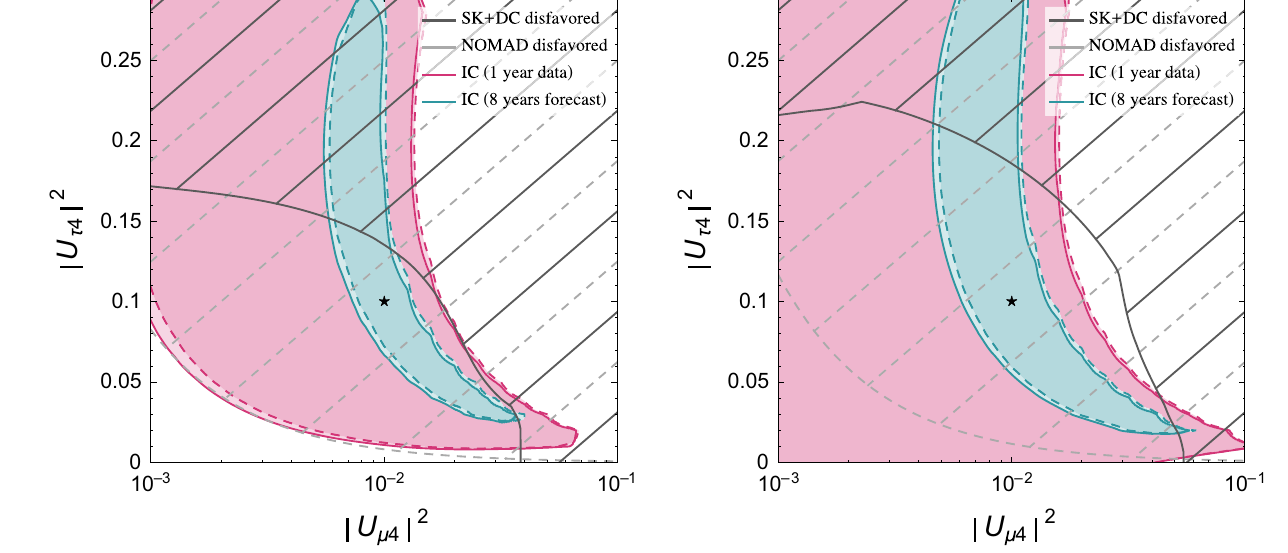
(markedwithastar).Thefull(dashed)linesshowtheboundsfor δ 24 = 0 ( δ 24 = π ). The solid (dashed) hatched regions are disfavored by Super- Kamiokande [40] and DeepCore [54] (NOMAD [56]) data at the same